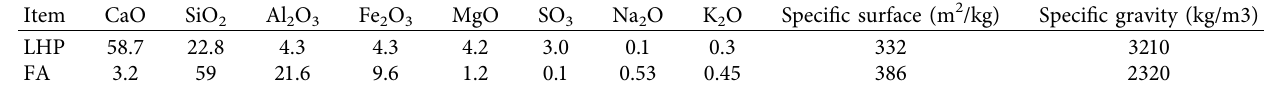
Table 1: Chemical and physical composition of LHP cement and FA (%).